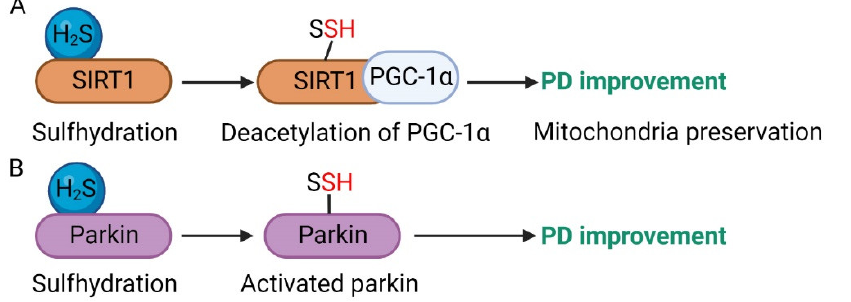
Figure 3. Proposed neuroprotective mechanisms of H 2 S in regulating PD. ( A ) H 2 S sulfhydrates the SIRT1 and promotes the activation of SIRT1, which subsequently activates the deacetylation of PGC-1α, resulting in mitochondria preservation and PD improvement. ( B ) H 2 S promotes the activation of parkin through sulfhydration, which finally leads to PD improvement. The red fonts represent sulfhydryl group. This model was created using BioRender (https://biorender.com/, accessed on 19 November 2022).